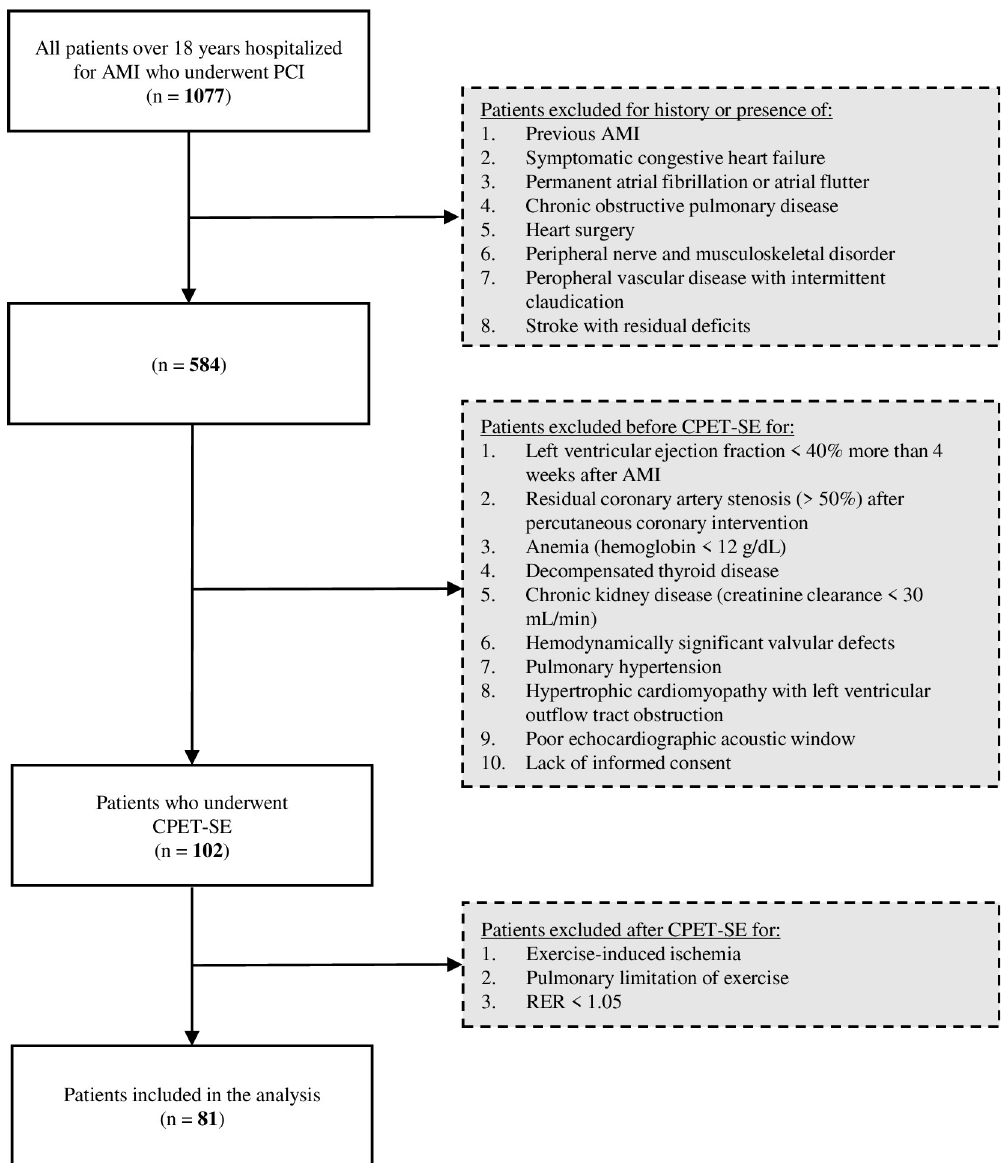
Fig 1. Study flow chart. Abbreviations: AMI, acute myocardial infarction; CPET-SE, combined stress echocardiography and cardiopulmonary exercise testing, FEV 1, forced expiratory volume in the first second; IVC, inspiratory vital capacity; PCI, percutaneous coronary intervention; RER, respiratory exchange